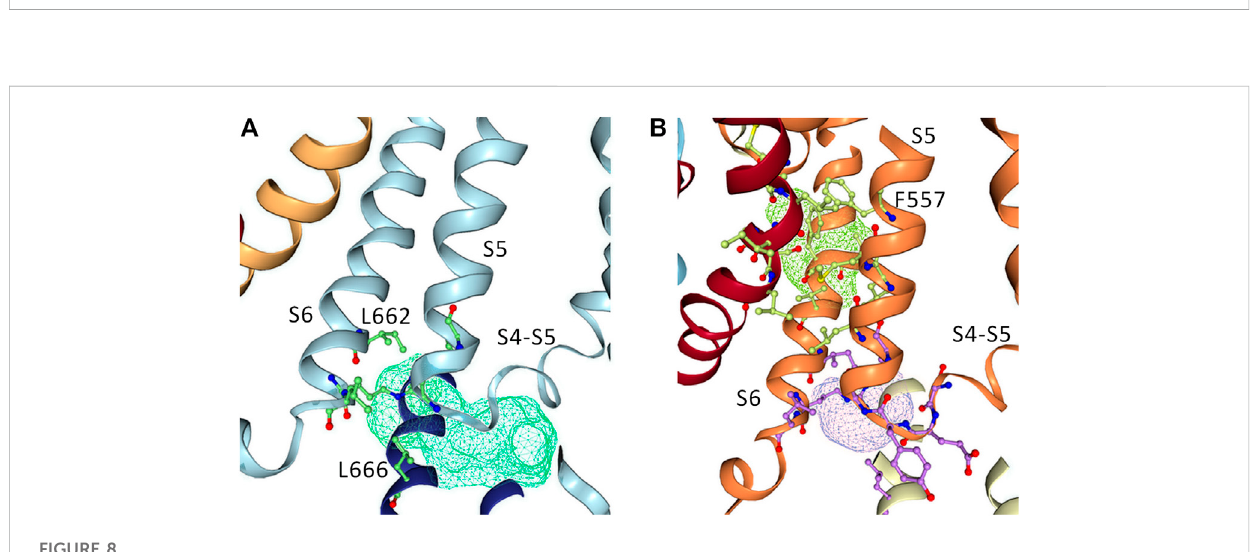
drug accessible pocket is shown in Figure 8A. Pockets were calculated using the protein pocket predicting program (Schöning-Stierand et al., 2020; Fährrolfes et al., 2017) (https://